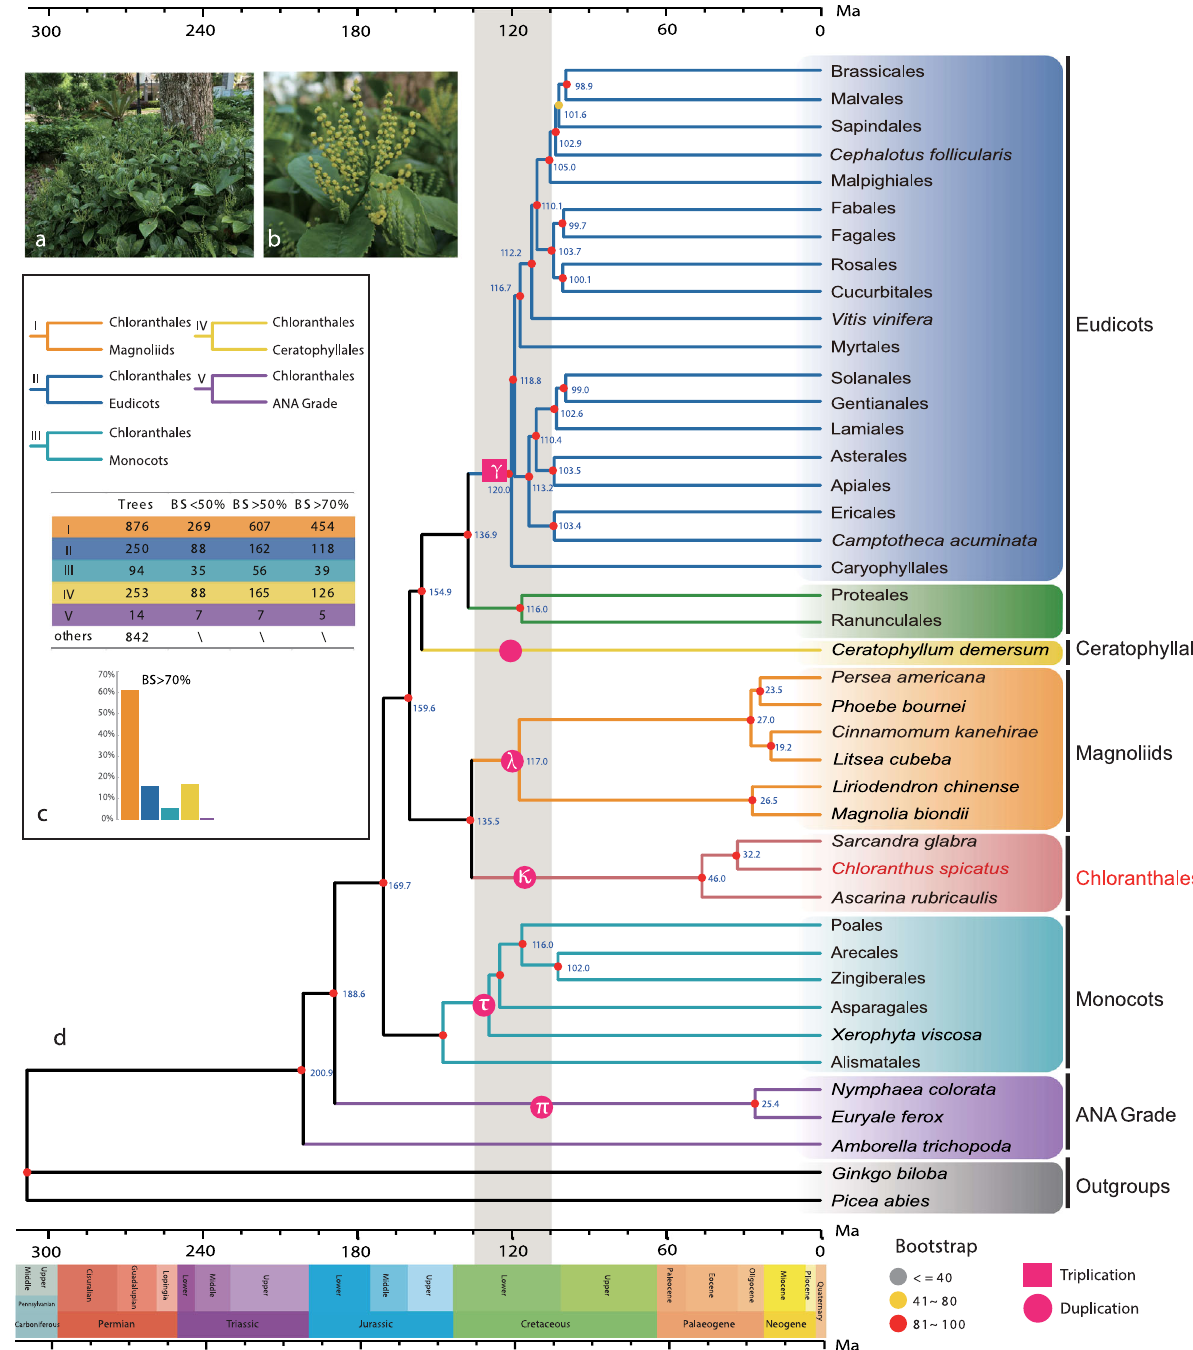
Fig. 1 Phylogenetic summary of the fl owering plants and placement of Chloranthaceae. a Chloranthus spicatus in Guilin Botanical Garden, China, and b at the in fl orescence stage (Photo credit: Qiang Zhang). c . A summary of phylogenetic placement of Chloranthaceae based on 2,329 low-copy nuclear (LCN) genes. In all, 61% of the gene trees placed Chloranthales as the sister lineage to magnoliids (bootstrap >70%). d Simpli fi ed backbone of the phylogenetic tree constructed in IQTREE using the 218 species data set, displaying the topology, polyploidy, and divergence times at the ordinal level. Whole-genome duplication/triplication events are positioned based on a previous report 33 . Source data underlying Fig. 1d are provided as a Source Data fi